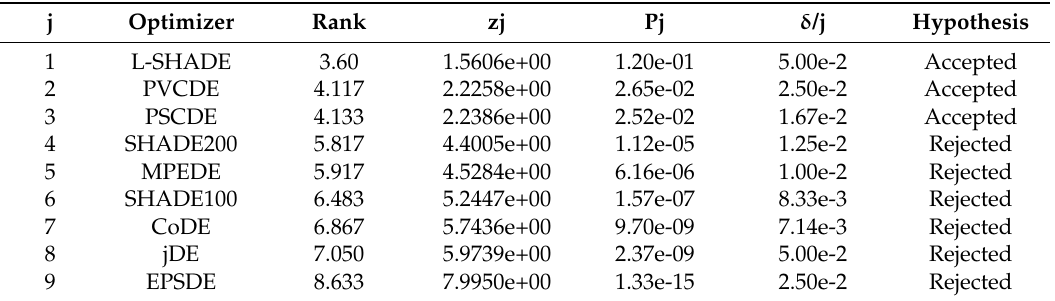
Table 7. Holm–Bonferrini procedure ranking L-PVCDE against algorithms (reference: L-PVCDE, Rank =